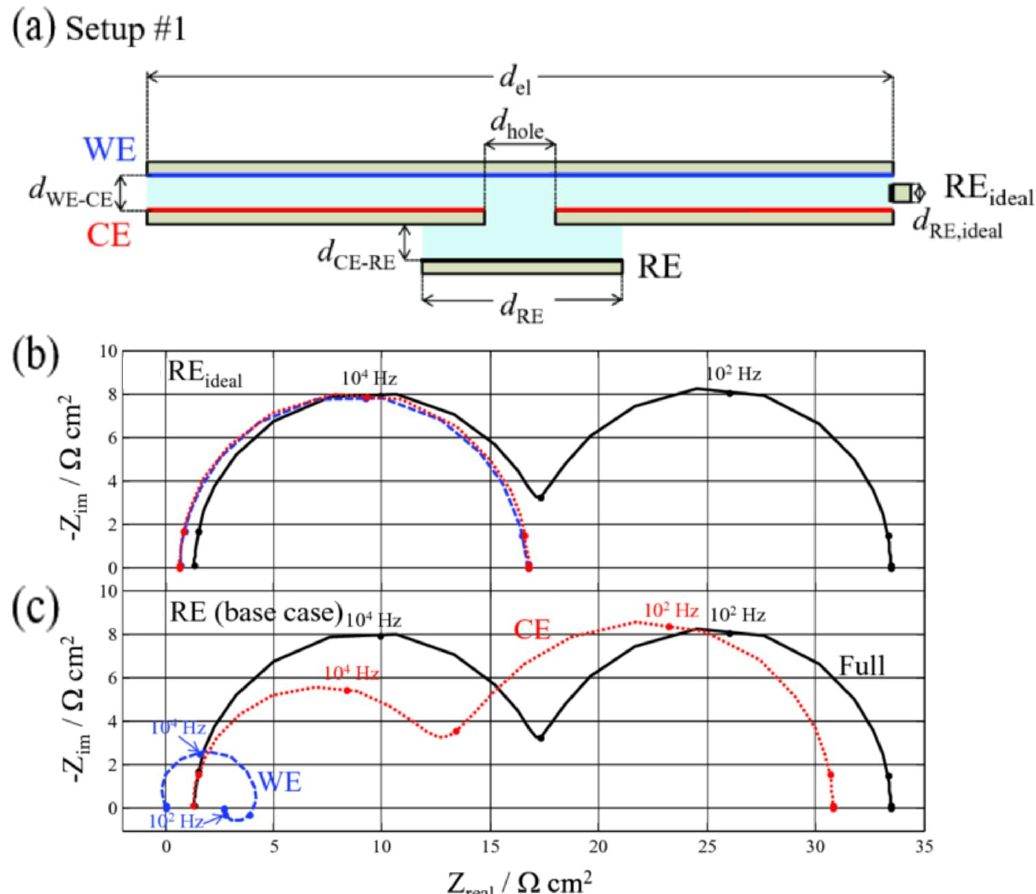
Figure 6. ( a ) Setup #1 with a hole in the CE of a three-electrode coin cell setup. Spectra are measured vs. ( b ) RE ideal and ( c ) RE. [57]. Reprint with permission [57]; Copyright 2014, IOP Science.